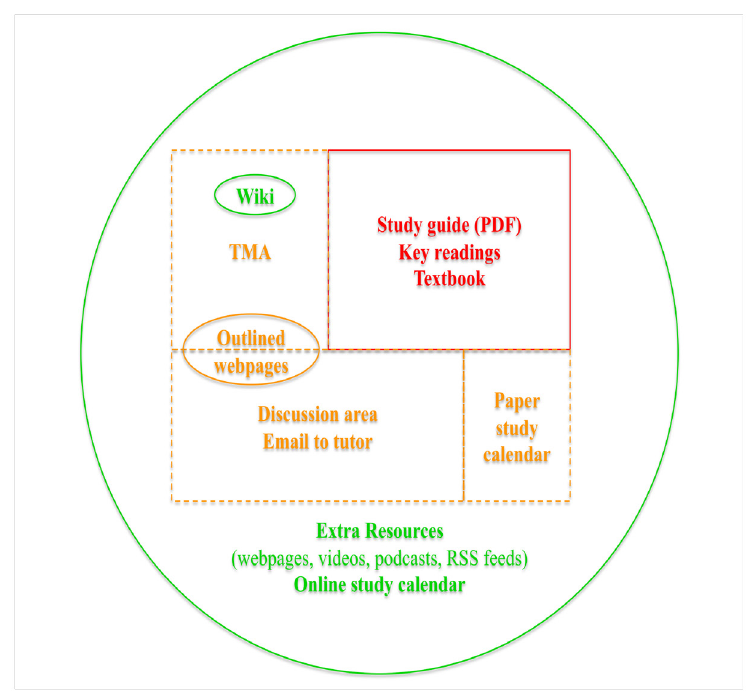
Figure 1 . Teaching tools supplied to students and toolbox (red – examinable resources; orange –optional resources but strongly recommended; green – purely optional